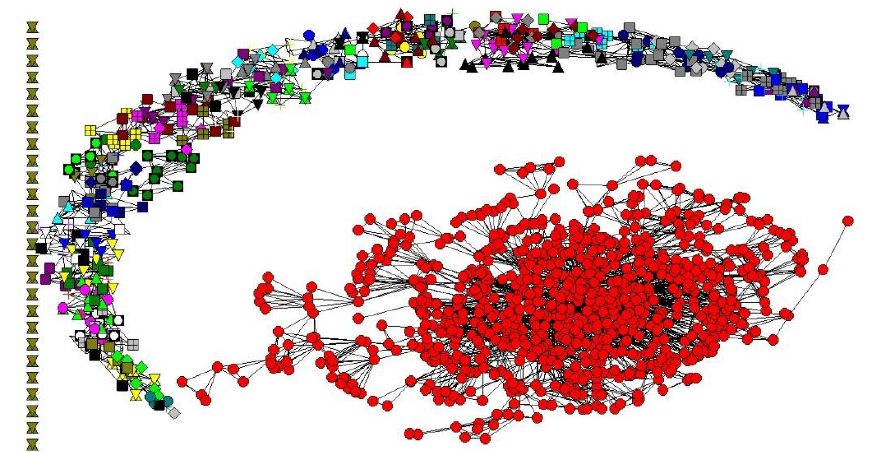
Figure 2. Overall networks related to shareholders (year: